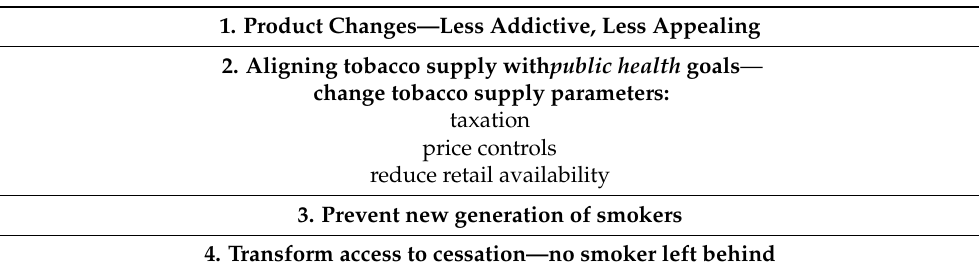
Table 1. Four major areas for action arising from the 2016 Endgame